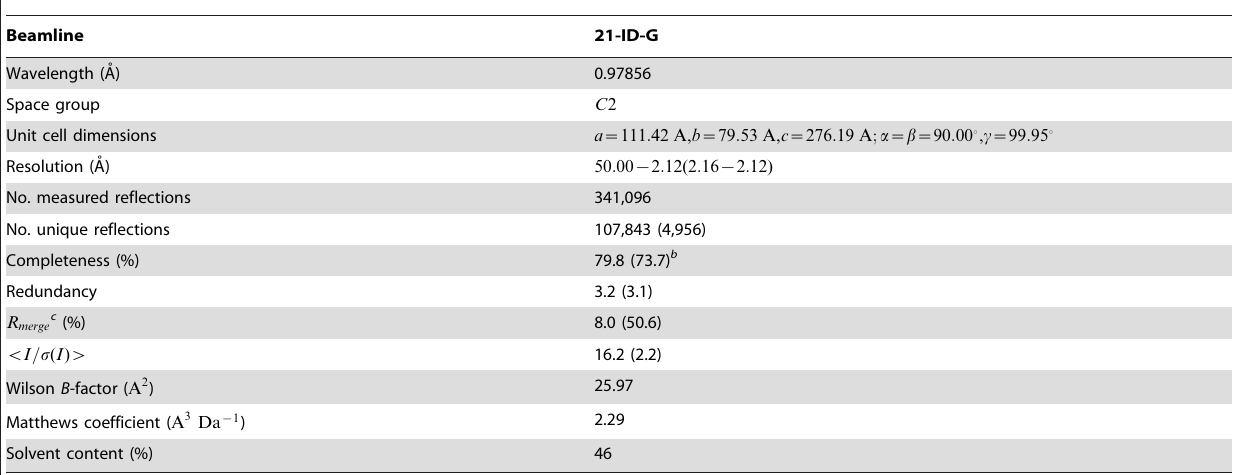
Table 3. Crystallographic data collection statistics for H6YfdE. a